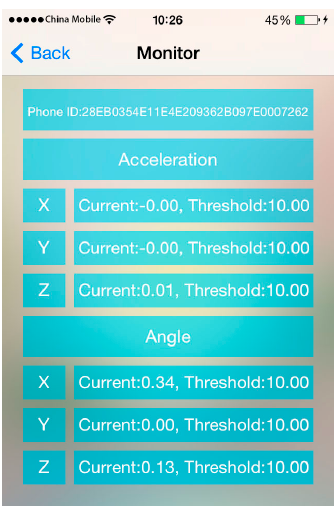
Figure 8. Controller interface.